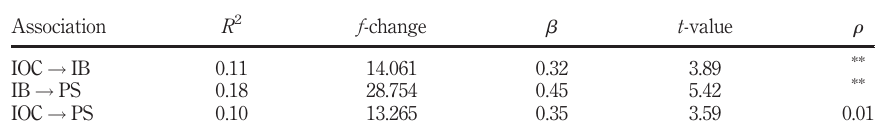
Table 3. Regression analysis